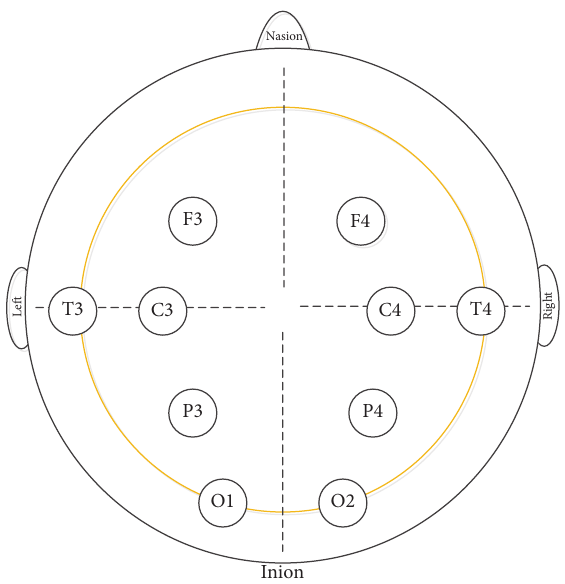
Figure 1: 10-channel EEG electrode